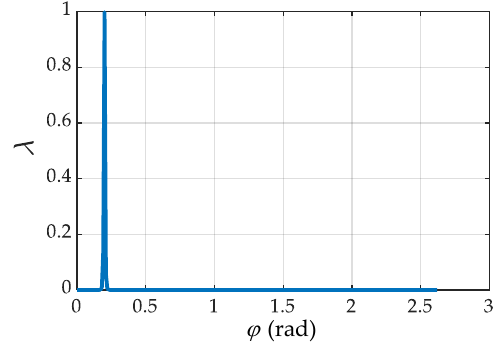
Figure 12. Type I .